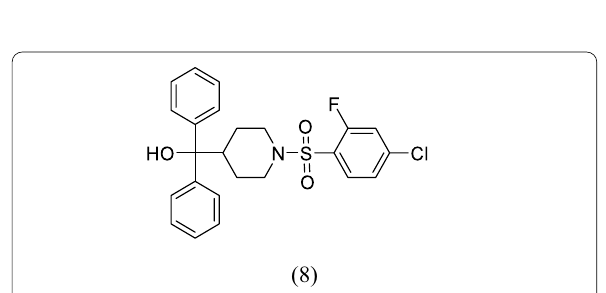
Fig. 13 Structure of N‑(piperidine‑4‑yl) benzamide derivatives